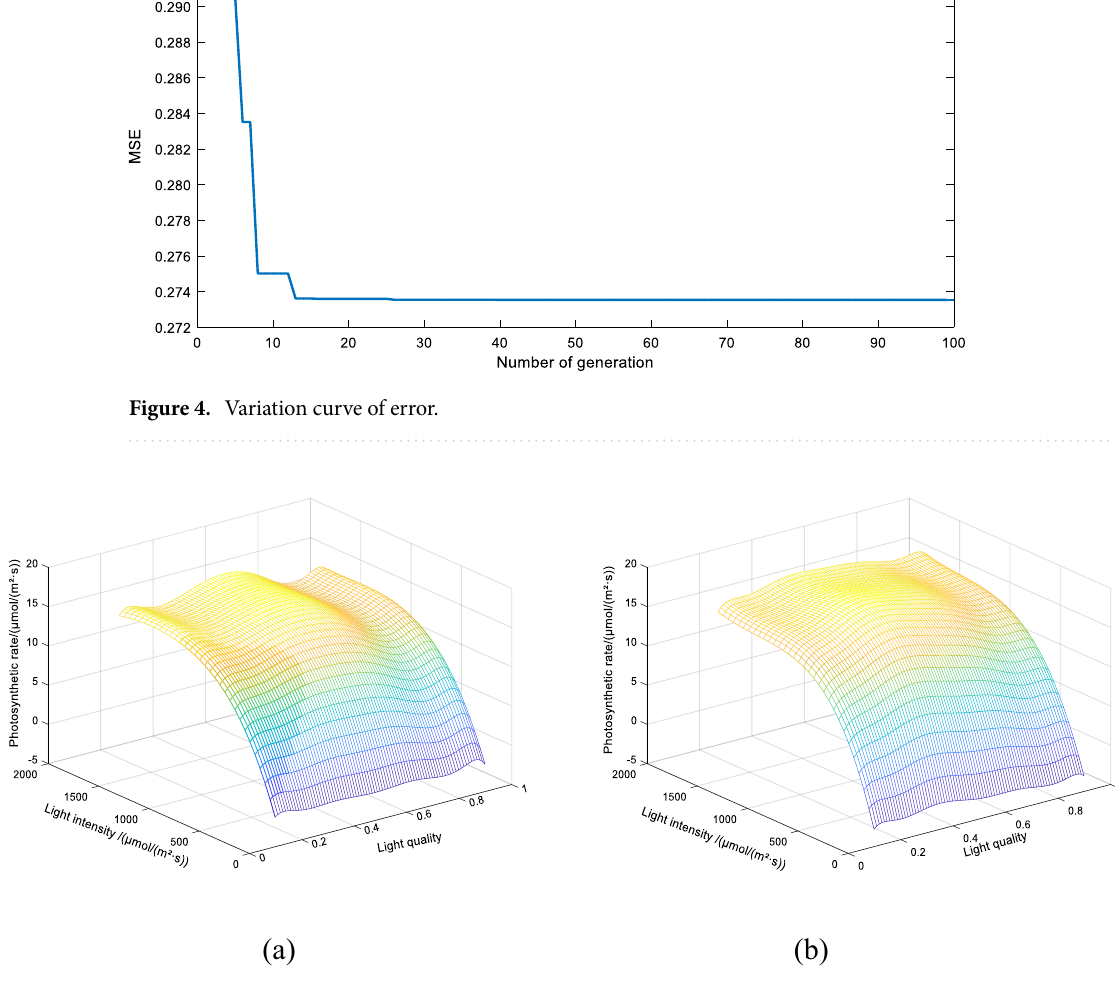
Figure 5. Photosynthetic rate prediction model at different temperatures. ( a ) At 21 °C; ( b ) at 27